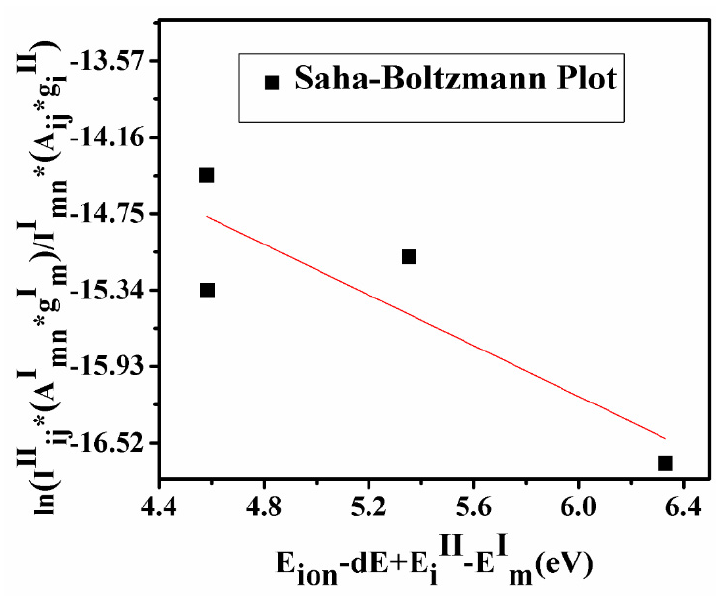
Figure 5. Saha–Boltzmann plot to determine the ionization